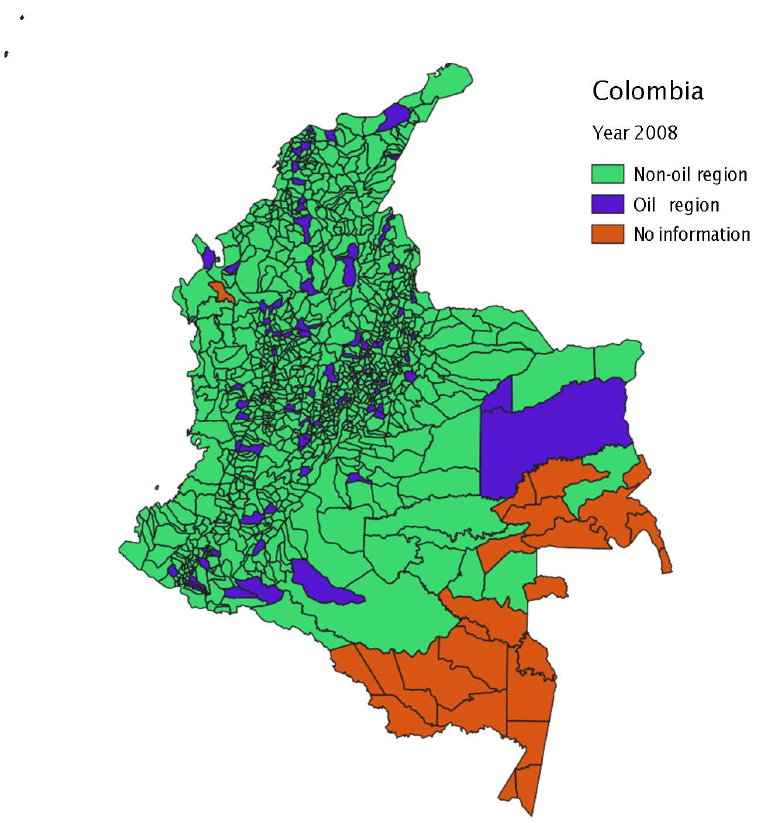
Figure 1. Oil producing vs. non-oil producing municipalities in Colombia. Source: Center for Studies on Economic Development (CEDE) at the University of the Andes .